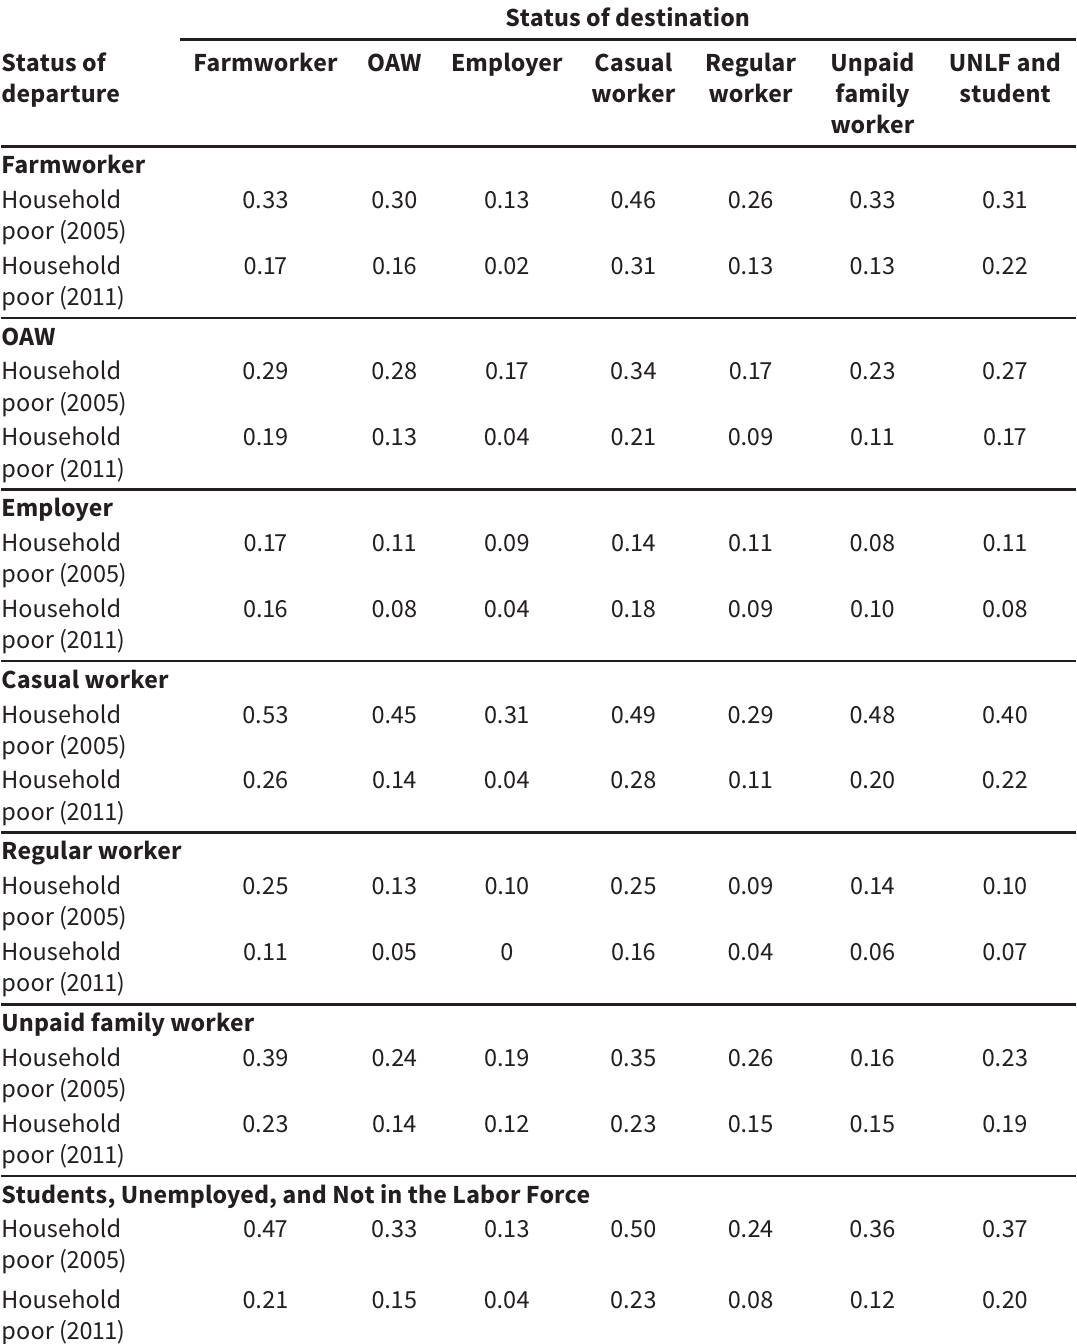
Table A4 Mobility and poverty